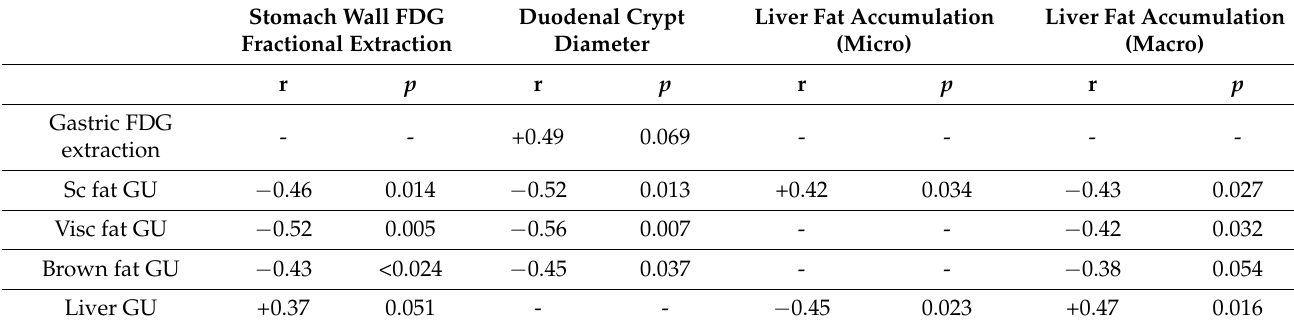
Table 2. Associations linking GI parameters and organ